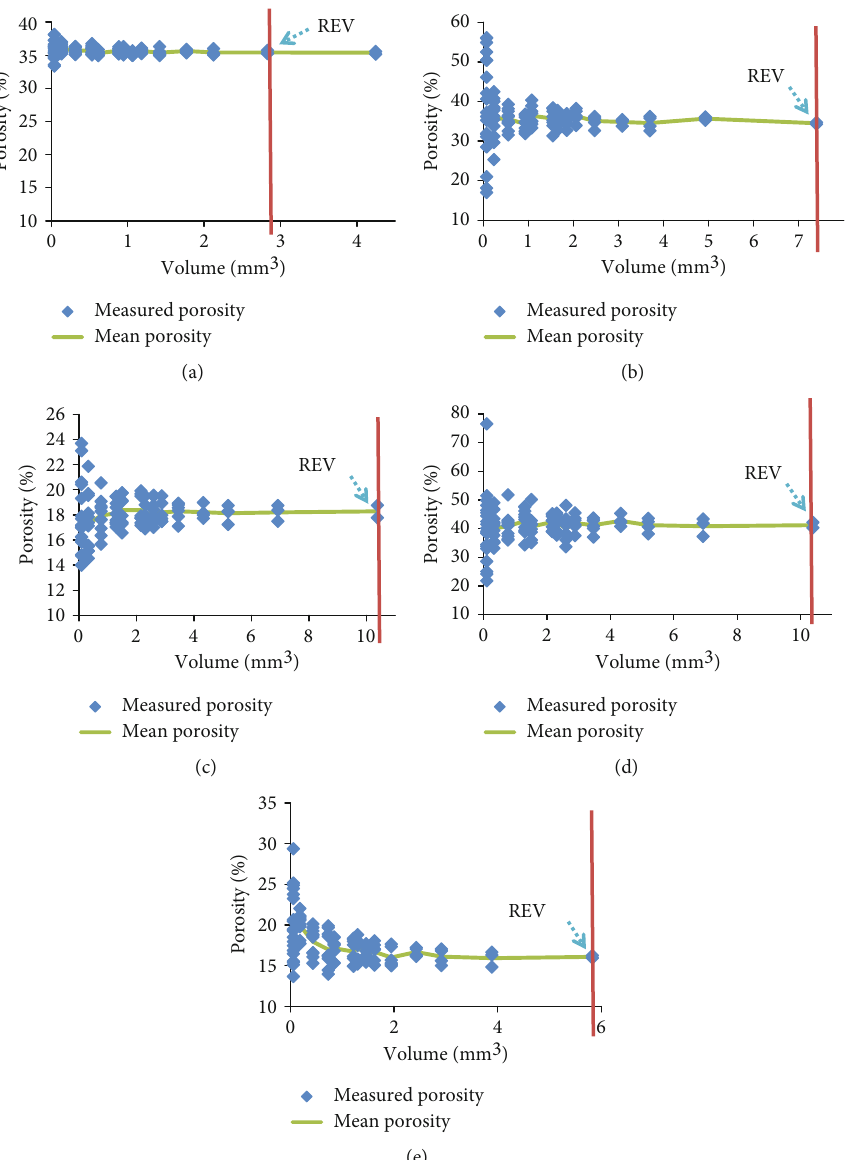
Figure 5: Empirical porosity variation (blue points) in the subvolumes of the fi ve samples examined: (a) glass bead pack, (b) sand pack, (c) Bentheimer sandstone, (d) Mount Gambier carbonate, and (e) St. Bees sandstone. The green line indicates the arithmetically averaged porosity of the sample. The vertical red line indicates the REV found by visual inspection.